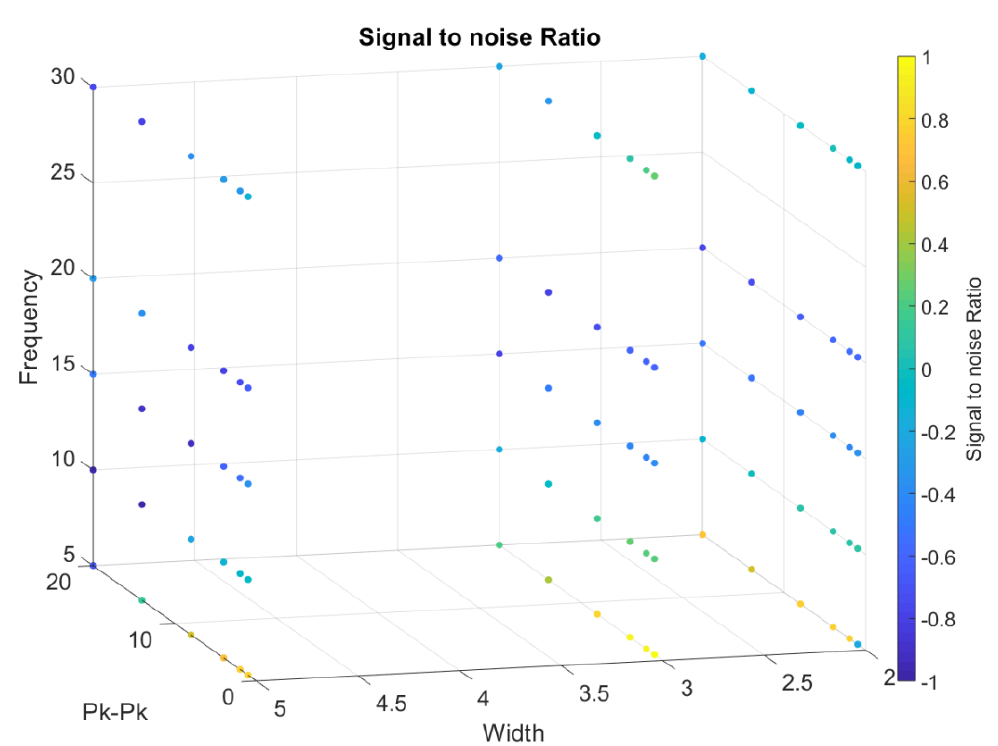
Figure 19. A 3D scatter plot for Signal to noise